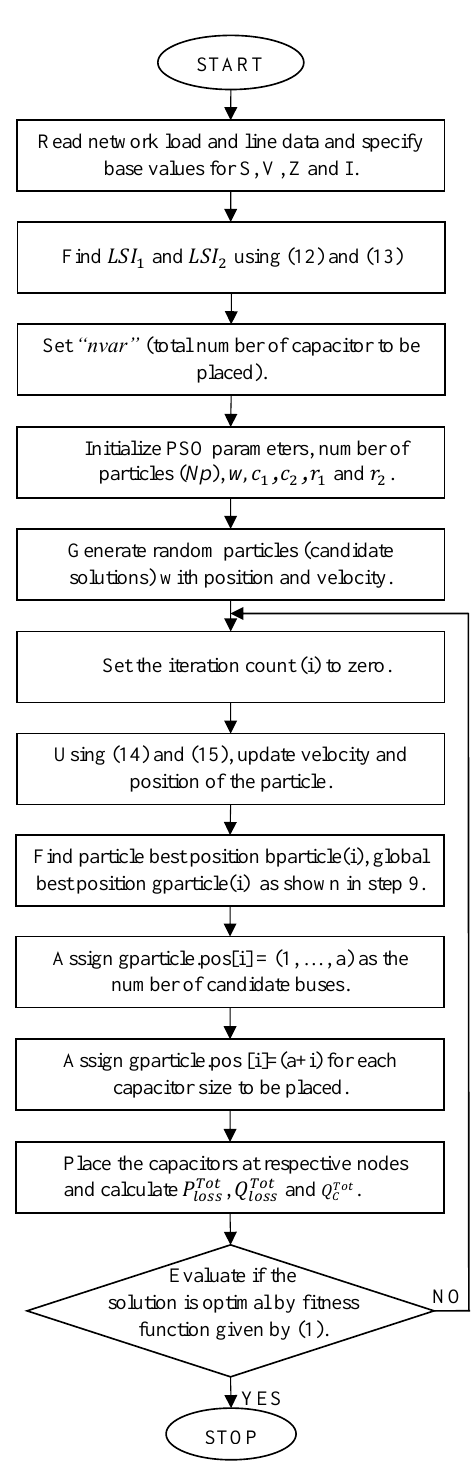
Figure 3. Flow chart for the proposed